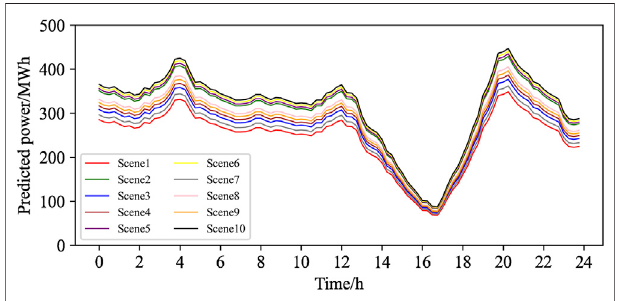
FIGURE 5 | Wind power curve graphs in different scenarios.